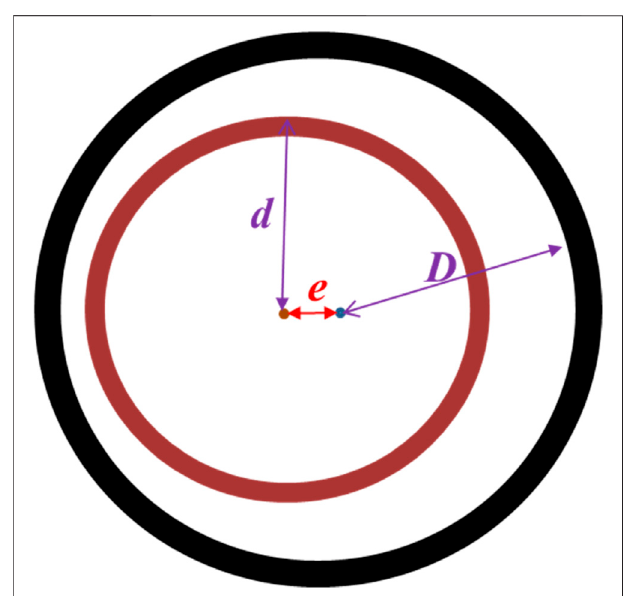
FIGURE 1 | The schematic diagram of casing